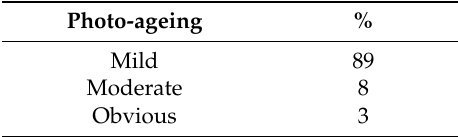
Table 5. Analysis of the photo-ageing of the pilot study subjects, based on Glogau scale.